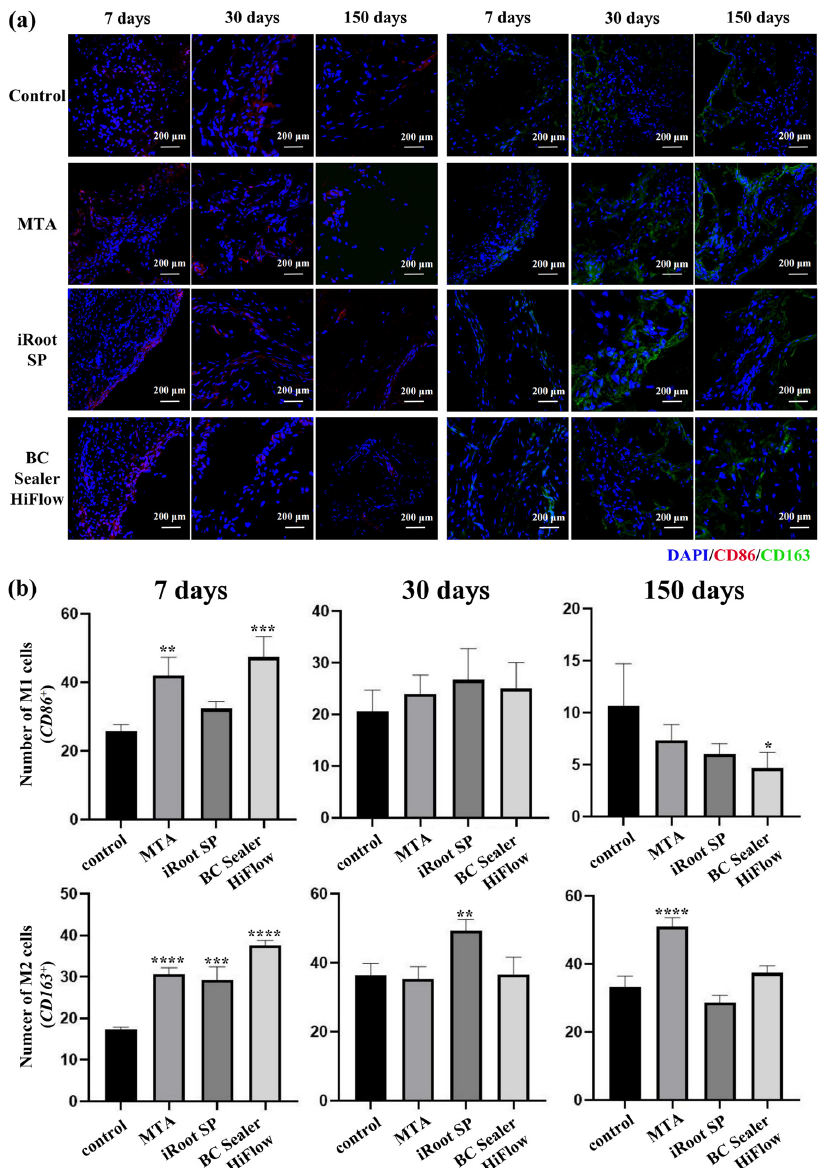
Figure 4. In vivo macrophage polarization in response to three biomaterials. ( a ) Localizations of CD86-positive and CD163-positive cells in rat subcutaneous connective tissues at 7, 30 and 150 days after implantation of empty dentine tubes (control), MTA, SP and HiFlow. The nuclei were stained with DAPI (400×, bar, 200 μ m). ( b ) Fluorescence semiquantitative statistical analysis of M1 and M2 macrophages at 7, 30 and 150 days. * p < 0.05, ** p < 0.01, *** p < 0.001, **** p < 0.0001 versus the control